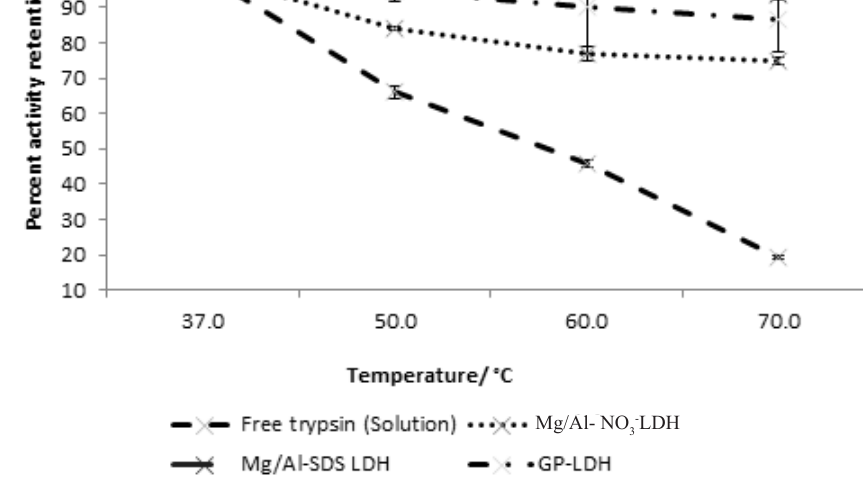
Figure 5: Plot of percent retention of activity vs. temperature.